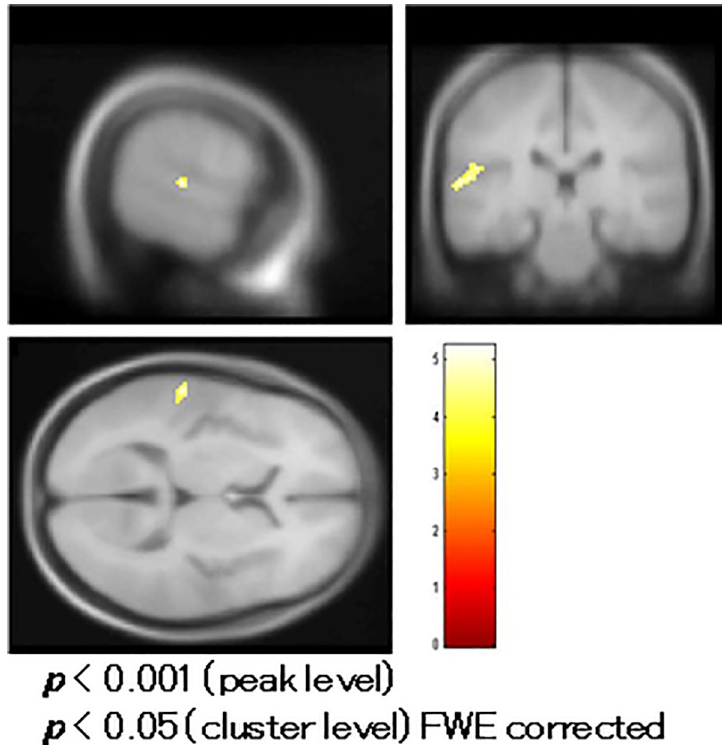
Fig 4. Grand average of functional magnetic resonance imaging (fMRI) in controls. Controls exhibited significant activation responding to omission in the left superior temporal gyrus (Brodmann area/BA 41).